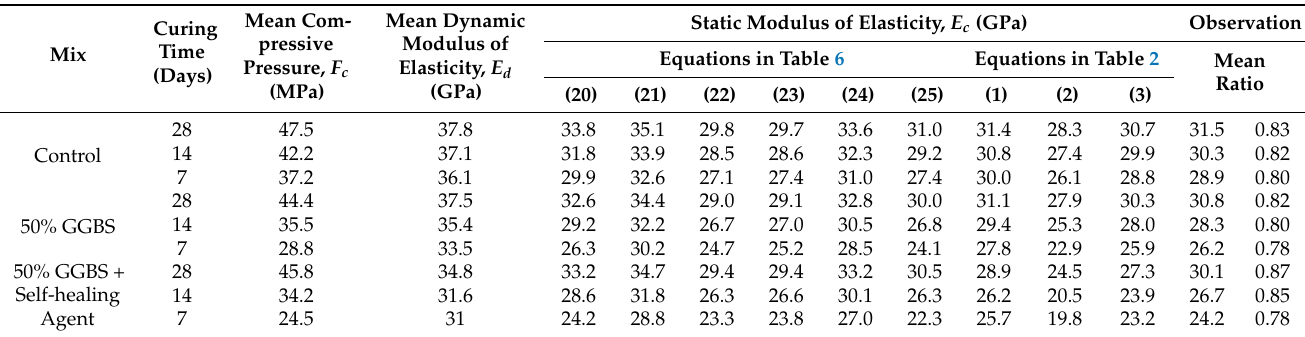
Table 13. Static modulus of elasticity determined from the compressive strength and the dynamic modulus of